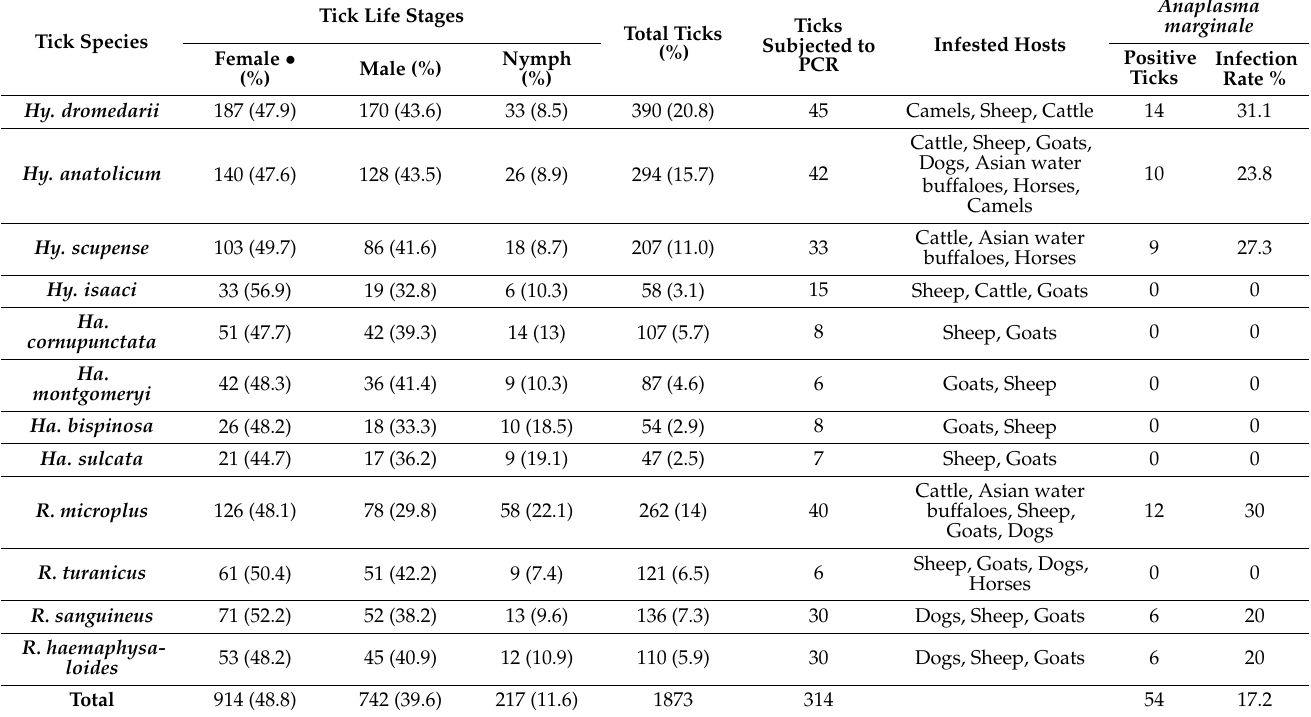
Table 2. Prevalence of ticks and the detection rate of Anaplasma marginale